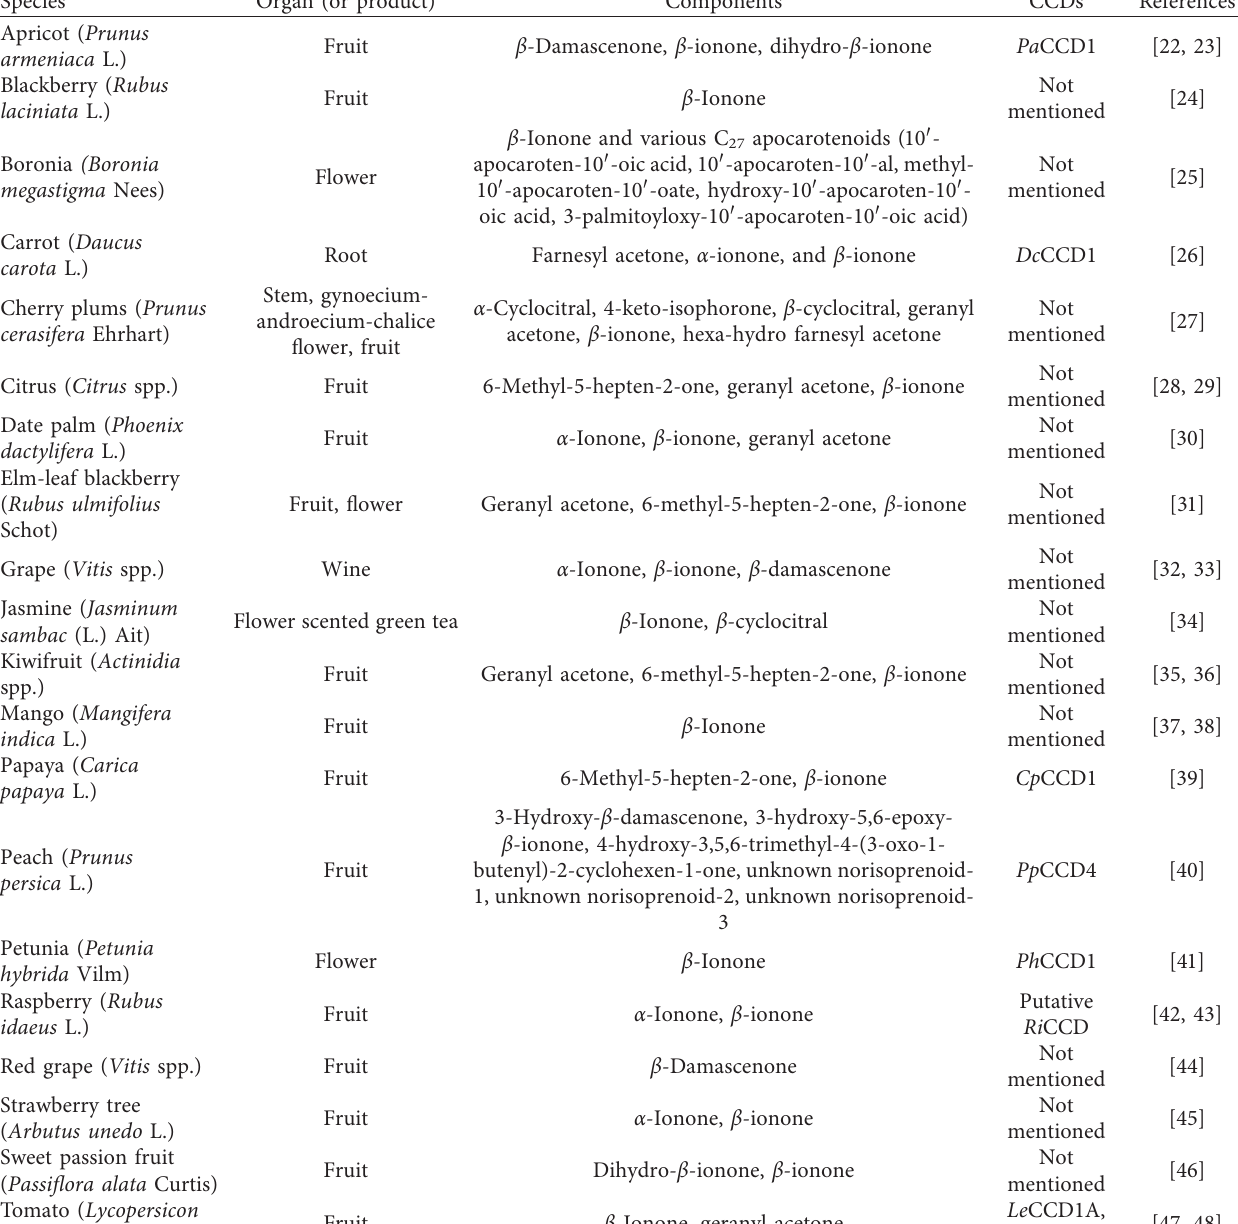
Table 1: Apocarotenoid aroma components and related carotenoid cleavage dioxygenases (CCDs) in some horticultural plants.